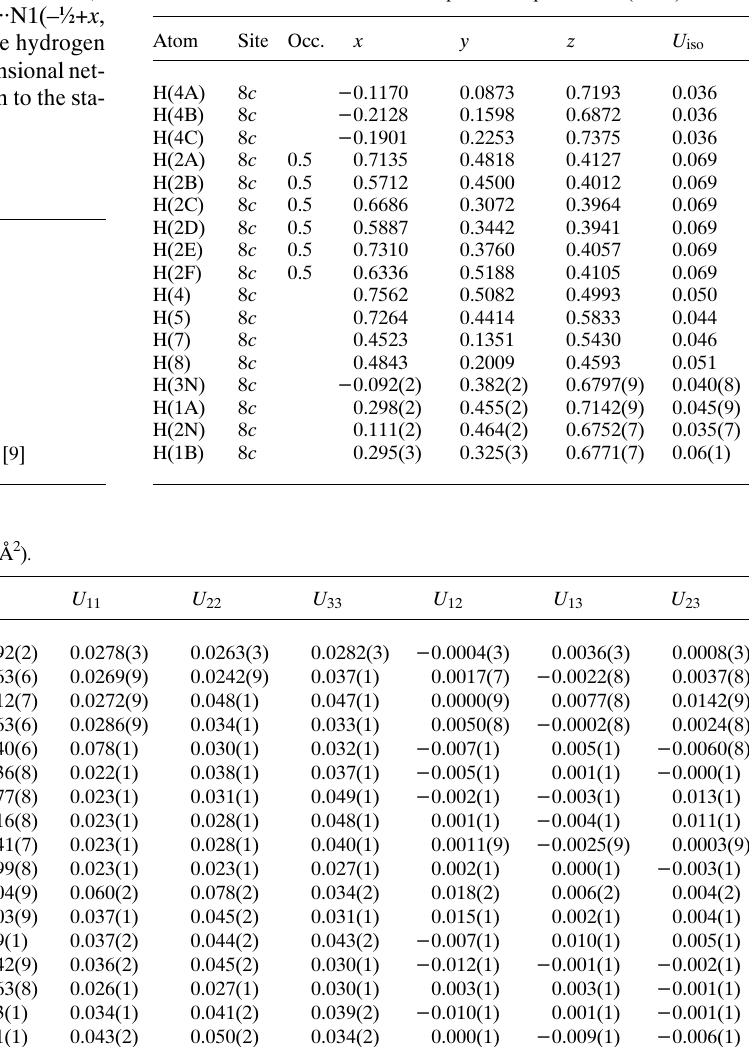
Table 2. Atomic coordinates and displacement parameters (in Å 2 ) .